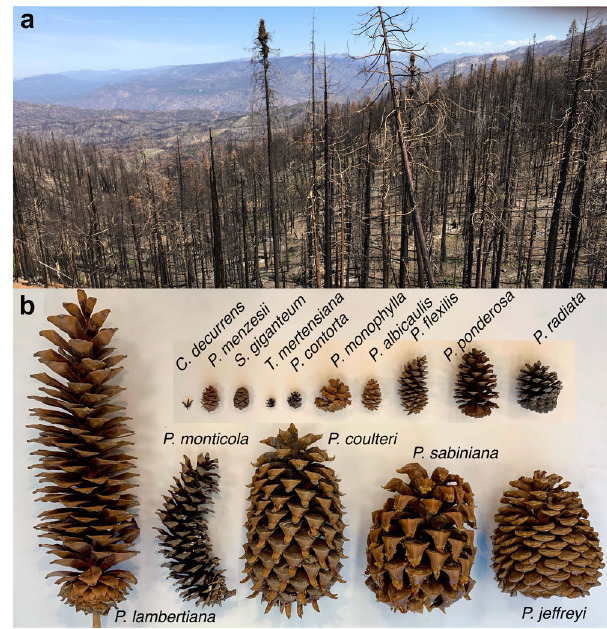
Fig. 1 Seed production quanti fi es forest regeneration